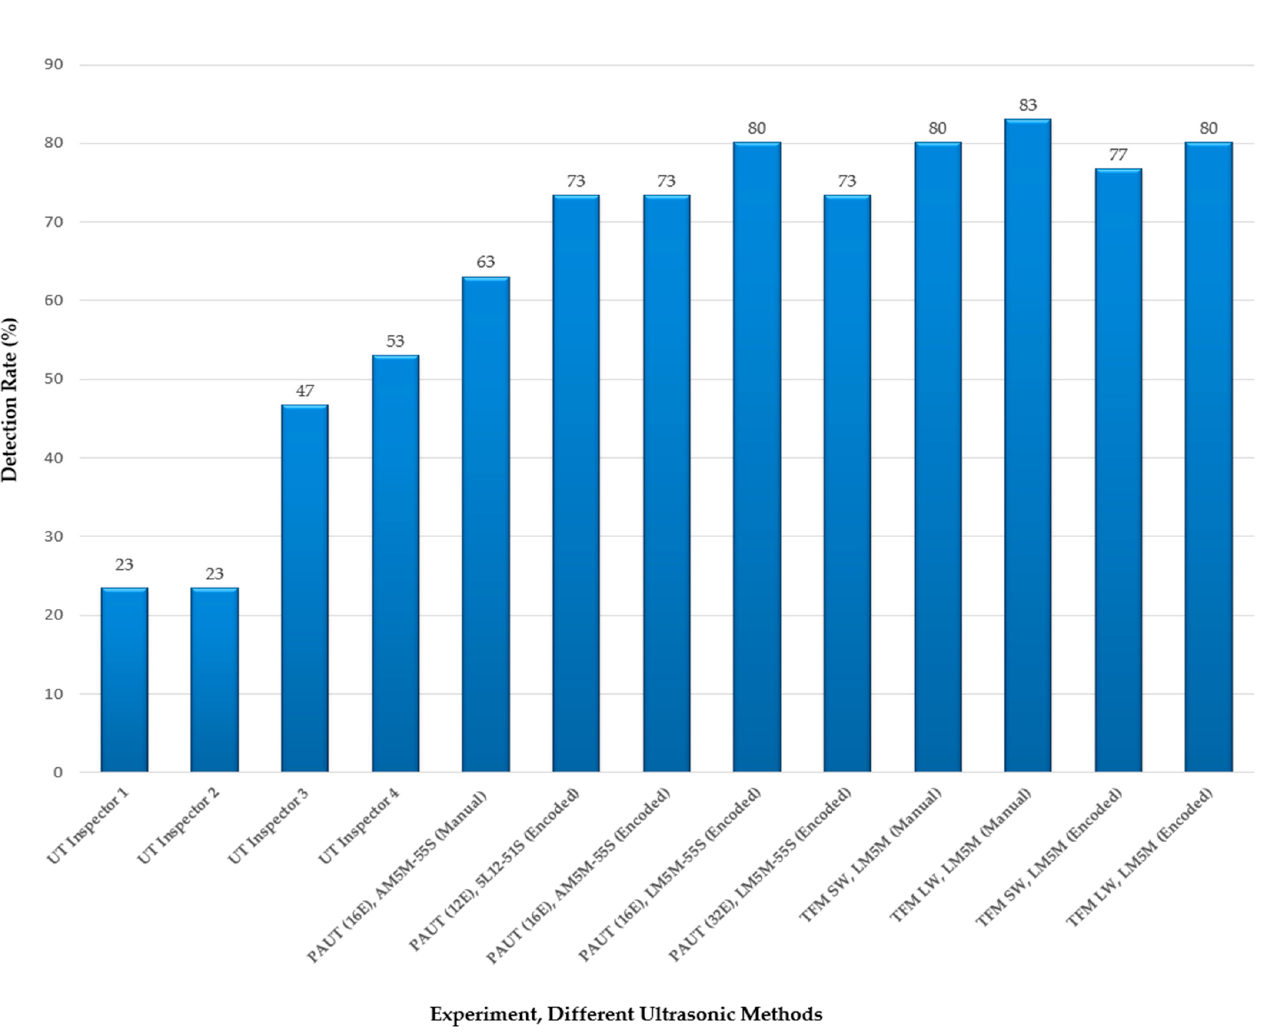
Figure 6. Experiment, Different ultrasonic methods.